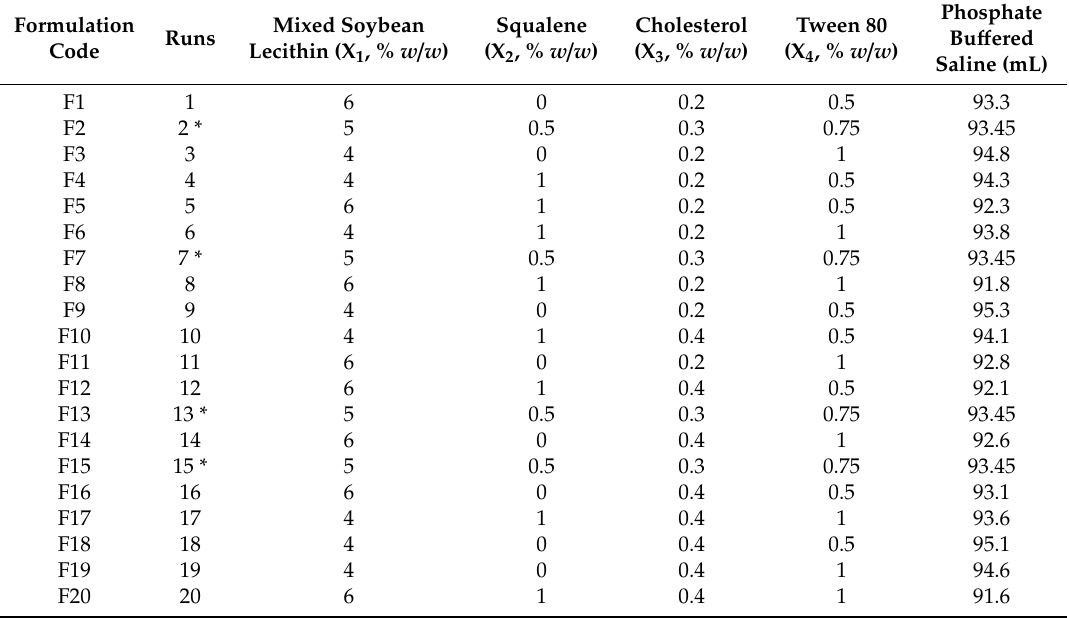
Table 1. Full factorial design for formulation compositions of